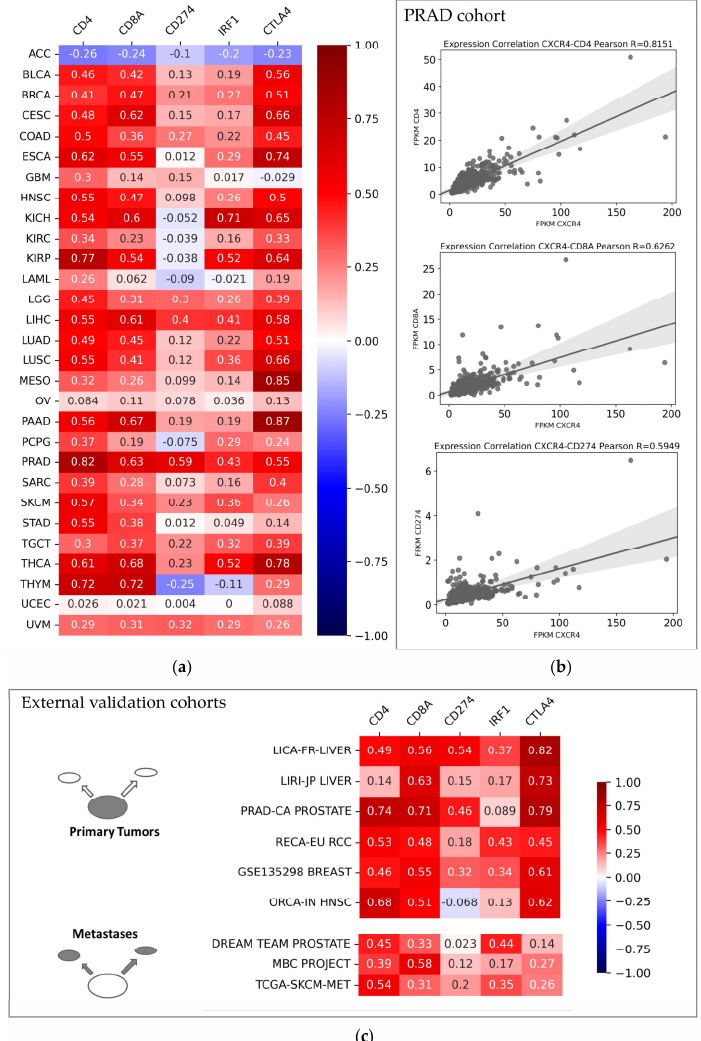
Figure 2. Pearson R values between CXCR4 expression and CD4, CD8A, CD274, IRF1, and CTLA4 expression within ( a ) TCGA pan-cancer cohort and ( b ) specifically within prostate cancer samples (PRAD cohort from TCGA database). ( c ) Pearson R values for respective genes in nine independent validation cohorts. FPKM: Fragments per Kilobase